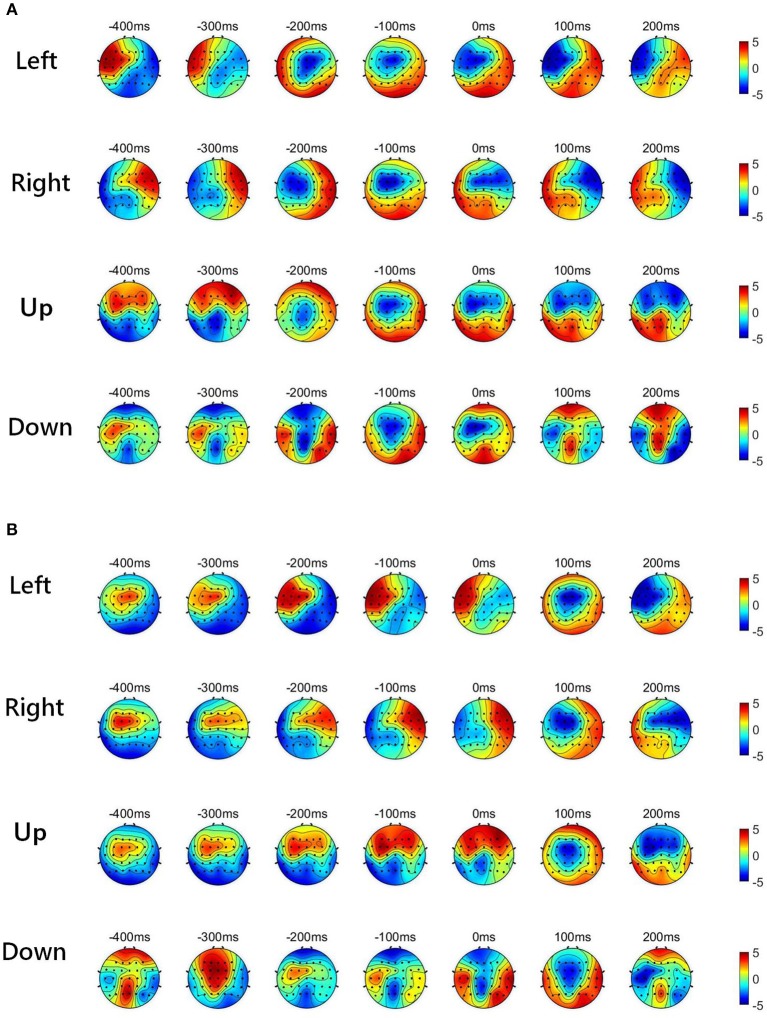
The time-resolved topographic maps of low-delta EEG features during the four-direction movements over subjects and sessions. (A) The grand average of low-delta EEG amplitude features. (B) The grand average of low-delta phase features.